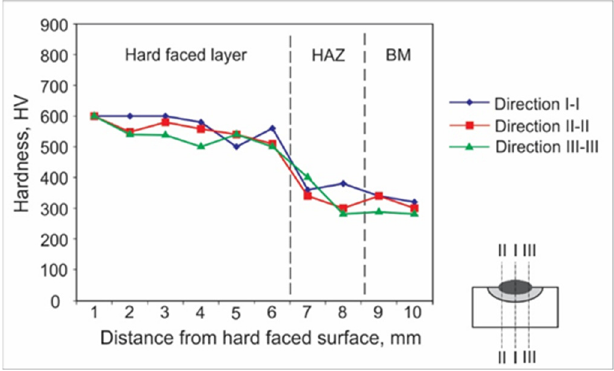
Figure 3. Hardness distribution in the hard-faced layer cross-section, BM-C45, FM-E DUR 600. Figure 4. Hardness distribution in the hard-faced layer cross-section, BM-42CrMo4, FM-E DUR 600.